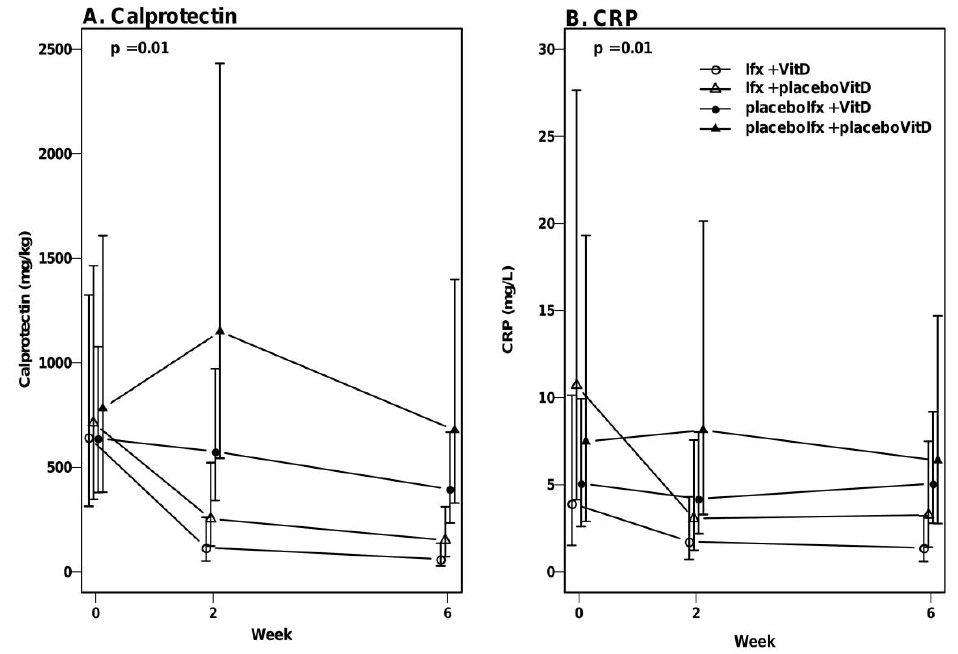
Figure 3. Calprotectin and CRP during active vitamin D treatment.